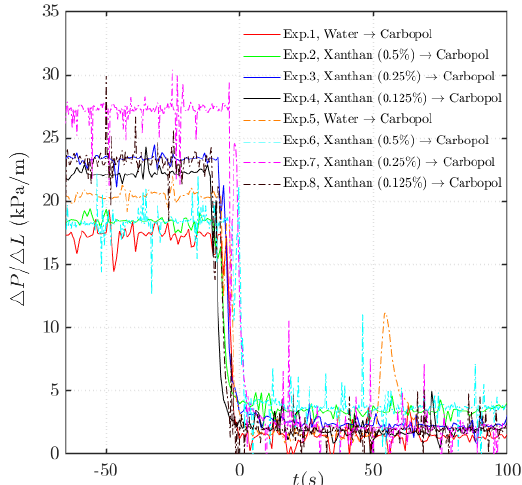
Figure 4. Recorded pressure drop profiles for each experiment— ∆ P / ∆ L for both Fluids 1 and 2. Additionally, the extent of the eccentric positioning of the casing pipe affected the annular pressure drop. The annular pressure drops for both fluids were lower in the experiments in the fully eccentric annulus, as is well known. As per the reported pressure drops in Table 3, the increase in the annular frictional pressure drop caused by the decrease in eccentricity from 1.0 to 0.7 was more pronounced for a yield-stress displaced fluid than for the Newtonian or power law displacing